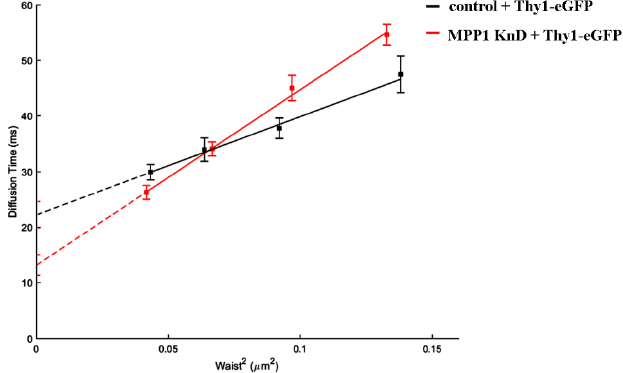
Figure 4. MPP1 affects the dynamics and confinement of Thy-1 in raft nanodomains. The diffusion law of eGFP-Thy-1 transfected control and MPP1 KnD cells. law of eGFP-Thy-1 transfected control and MPP1 KnD